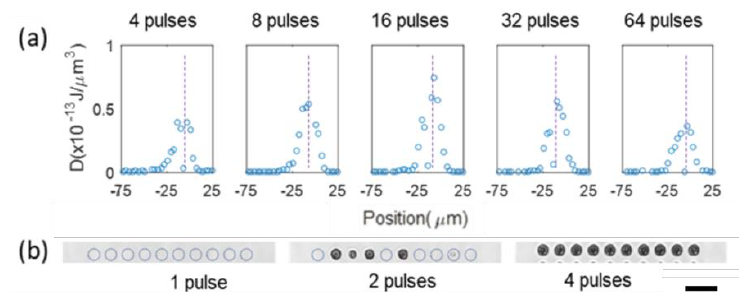
Fig. 1. Accumulating energy density with pulse trains. (a) Estimated absorbed energy densities (peak) along the propagation distance (geometrical focus at zero-position) with trains of femtosecond pulses (5.6 THz) focused with NA=0.45 (b) Top-view infrared images of modifications produced with trains of 4-ps pulses focused (NA=0.85) at 300µm below the surface. All irradiation energies are the same (2.1µJ/train) repeated 10 times for direct comparisons of damage probabilities). The scale bar is 50